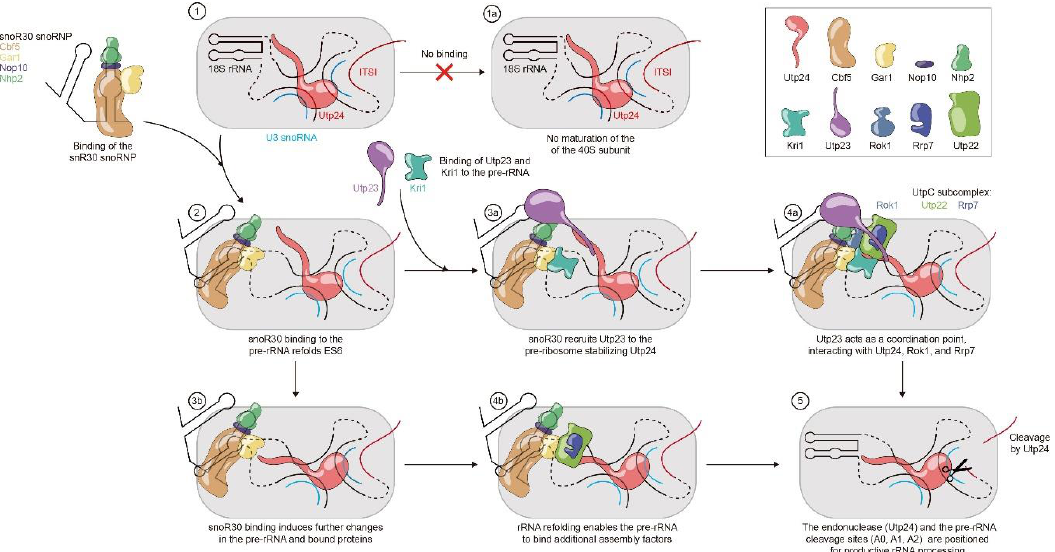
Figure 5. Putative molecular mechanisms of snR30 during ribosome biogenesis. A schematic of the SSU processome is shown as a light gray background with Utp24 (cyan) bound to the 18S rRNA and U3 snoRNA ( 1 ). In the absence of snR30, no processing occurs ( 1a ). Base-pairing of snR30 to the rm1 and rm2 sites in expansion segment 6 (ES6) of 18S rRNA causes the two hairpins in ES6 to unfold and to instead refold into a single hairpin ( 2 ). Once bound to the SSU processome, snR30 likely recruits the proteins Utp23 and Kri1 to the SSU processome ( 3a ). Utp23 may act as a coordination point interacting with several other proteins such as Rrp7, Rok1, and the endonuclease Utp24 ( 4a ). These interactions could lead to a stabilization and possible reorganization of the SSU processome, allowing processing to occur, e.g., by bringing the endonuclease(s) (Utp24 or Rcl1) to the pre-rRNA cleavage sites ( 5 ). Alternatively, or in addition, the rearrangement of ES6 upon snR30 binding as well as other folding and unfolding events in rRNA caused by snR30 may induce conformational changes throughout the 18S pre-rRNA ( 3b ). This could lead to repositioning of already bound factors like Utp24 and to the recruitment of essential factors like the UtpC subcomplex ( 4b ). Ultimately, these conformational changes in the SSU processome correctly position the endonucleases relative to the pre-rRNA cleavage site within the SSU processome ( 5 ). snR30 and the 18S section of the pre-rRNA is black, the ITS1 of the pre-rRNA is red, and U3 snoRNA is depicted in light